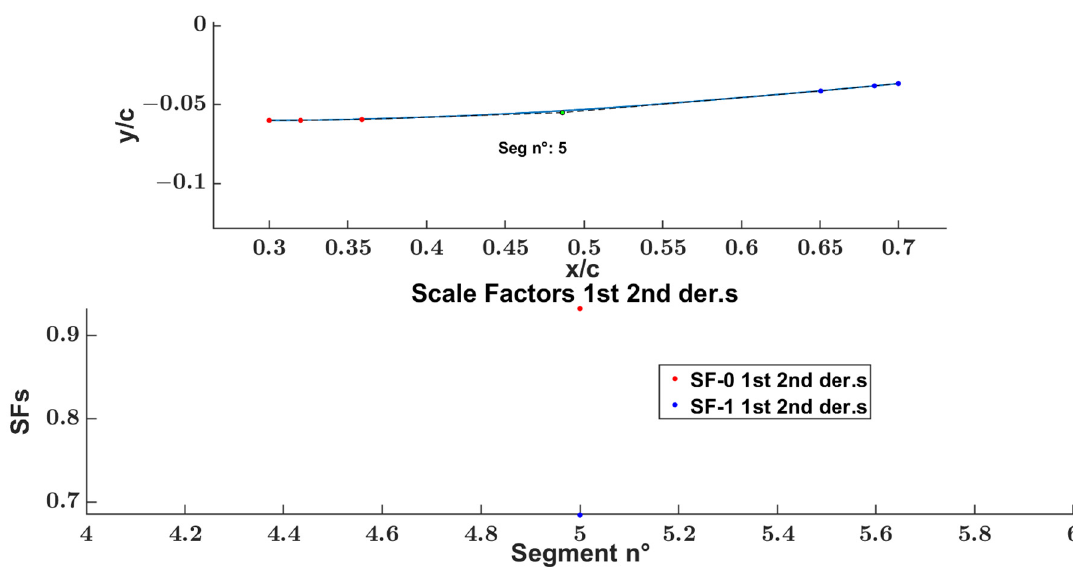
Figure 14. NACA 0012 Scale factors external optimization cycle segment 5